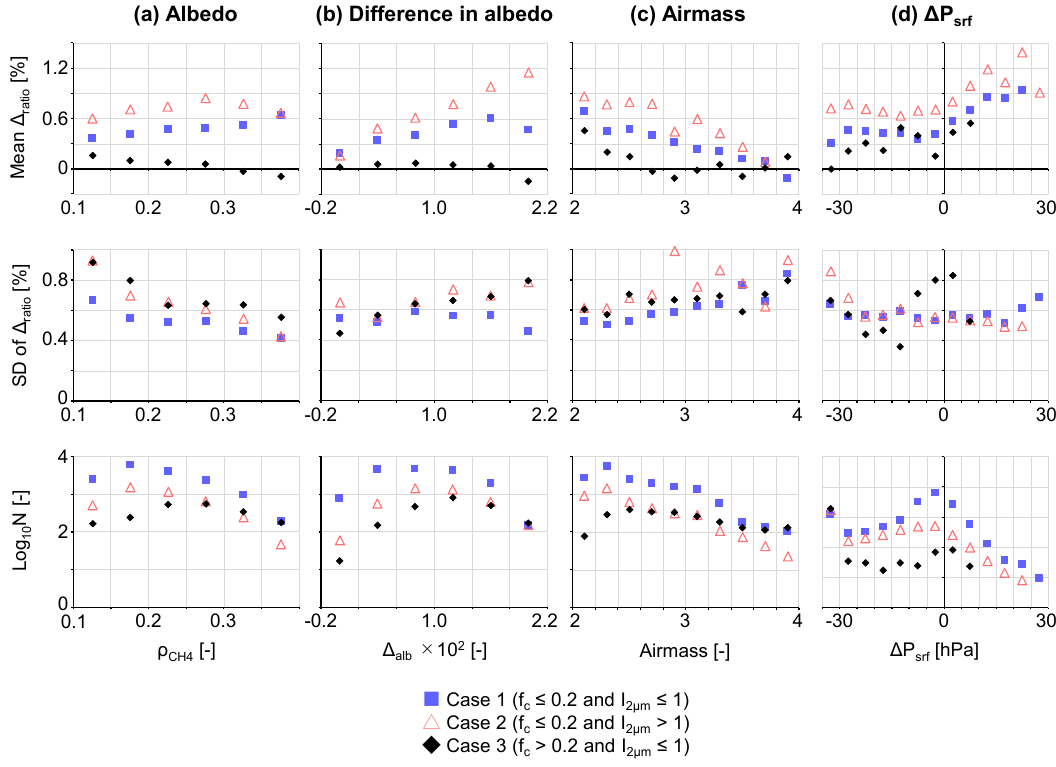
Figure 4. Variation of the relative difference in the ratio component between GOSAT and TCCON ( Δ ratio ) according to the related variables: ( a ) retrieved surface albedo of the CH 4 band ( ρ CH4 ); ( b ) difference in the retrieved surface albedo (CH 4 band minus CO 2 band, Δ alb ); ( c ) airmass; ( d ) deviation of the retrieved clear-sky surface pressure from its prior ( Δ P srf ). In each panel, the mean and standard deviation (SD) of Δ ratio and the number of data points (N) for each bin are presented. The results are separately plotted according to the cloud fraction (f c ) and the normalized 2 μ m band radiance (I 2 μ m ).